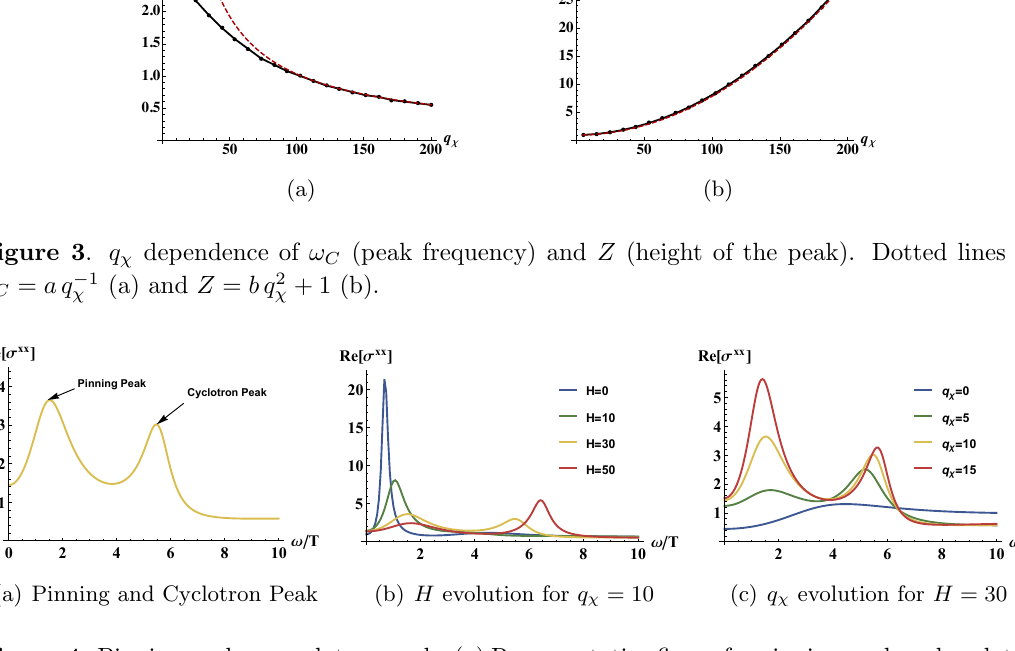
Figure 4 . Pinning peak v.s cyclotron peak: (a) Representative (cid:12)gure for pinning peak and cyclotron peak. q (cid:31) = 10 and H = 30. (b) H evolution with (cid:12)xed q (cid:31) = 10. (c) q (cid:31) evolution with (cid:12)xed H =